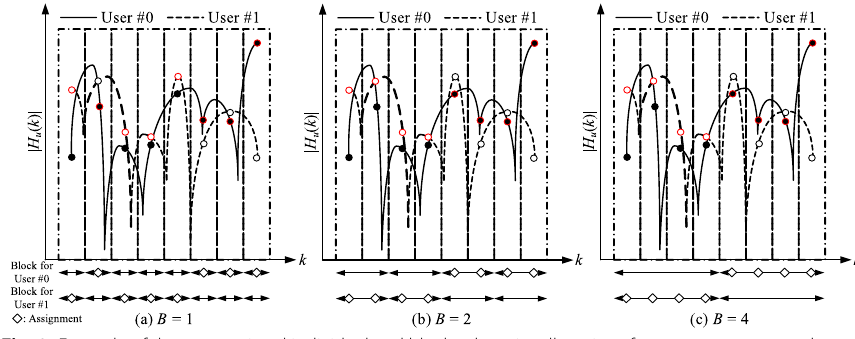
Fig. 2 Example of the conventional individual and block subcarrier allocations for N c = 8 , N u = 2 , and B = 1 , 2, and 4